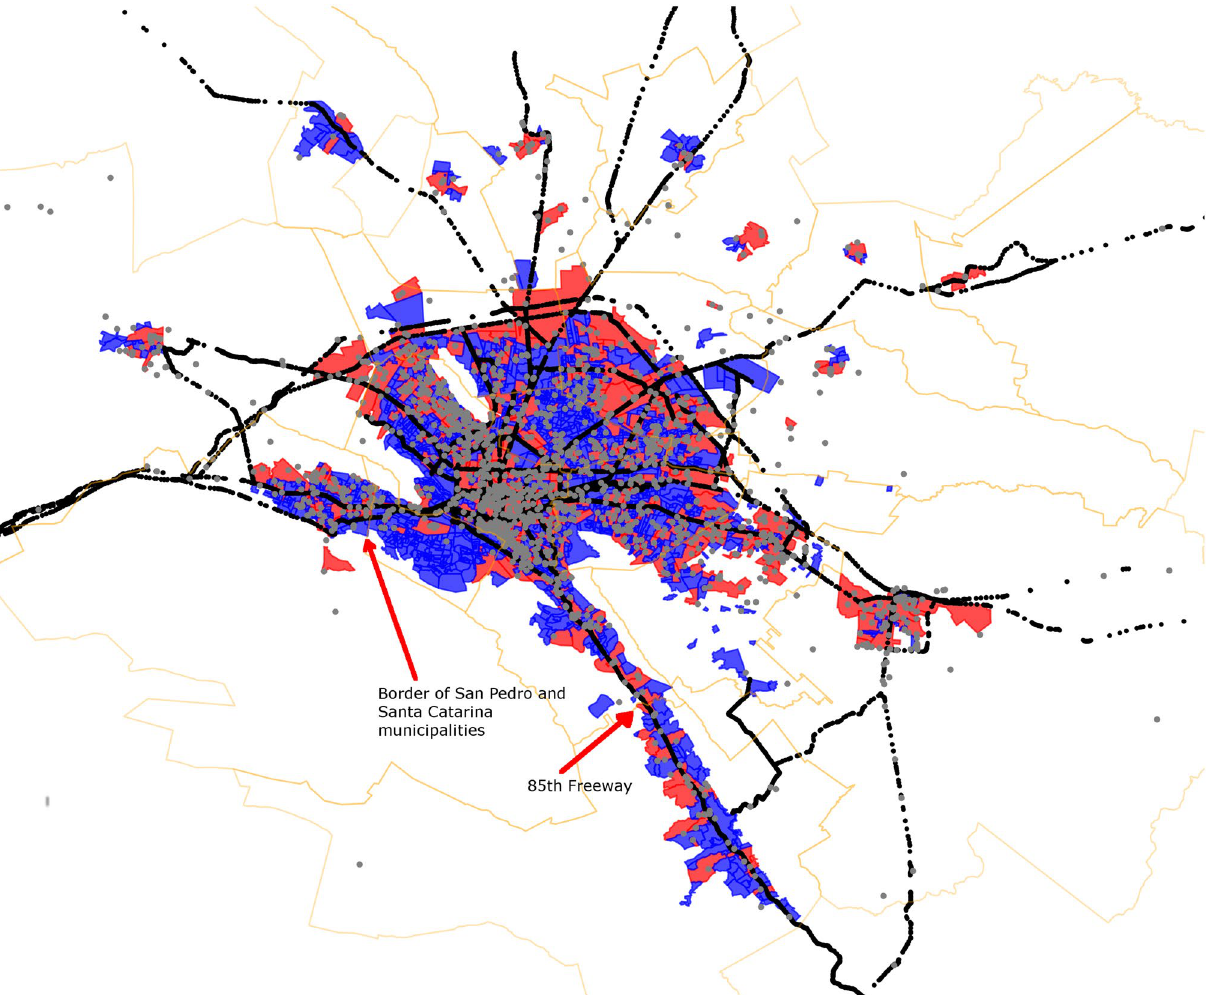
Figure 11. Geospatial distribution of homicides in MMA with